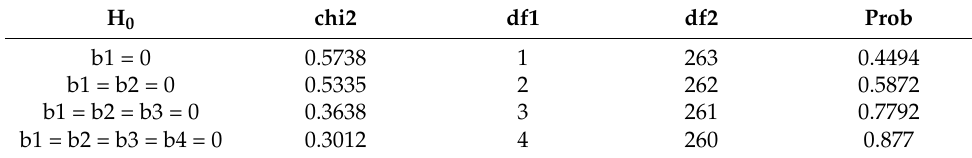
Table 4. Residual nonlinear test.